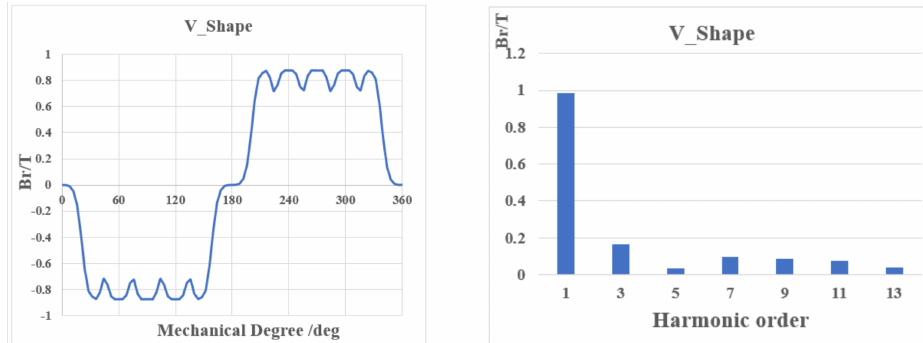
Figure 2. Br and its FFT of V-shaped rotor.